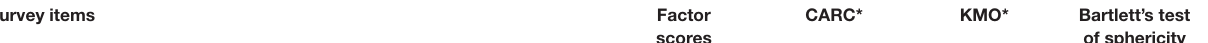
TABLE 4 | Factor scores and reliability tests for different agricultural stakeholders that influence farmers’ nutrient management practices and strategy decisions. Survey items Factor Please indicate how much influence the following sources of information have on your decisions about nutrient management practices and strategies. Public sector